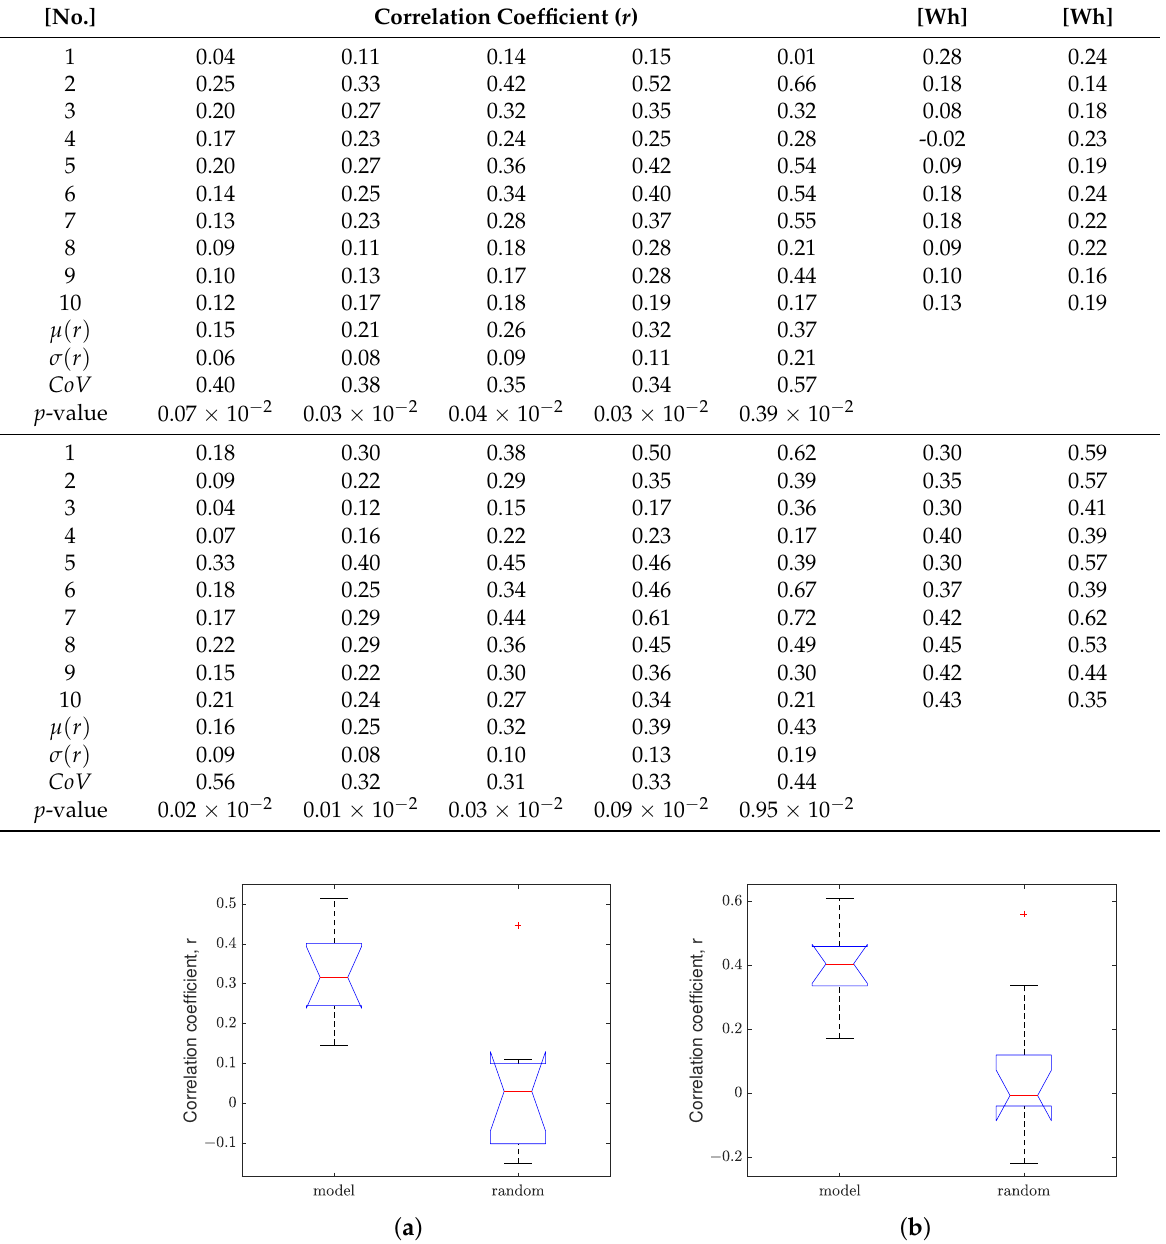
Figure 12. Box-plot of measured and randomly generated correlation coefficients for 10 car passes: ( a ) highway road and ( b ) urban